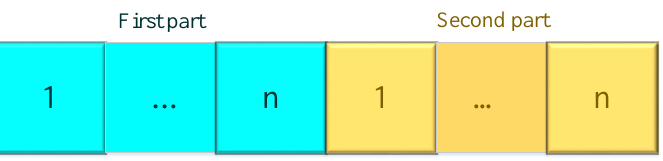
Figure 4. Position of a salp and a grasshopper and chromosome of an